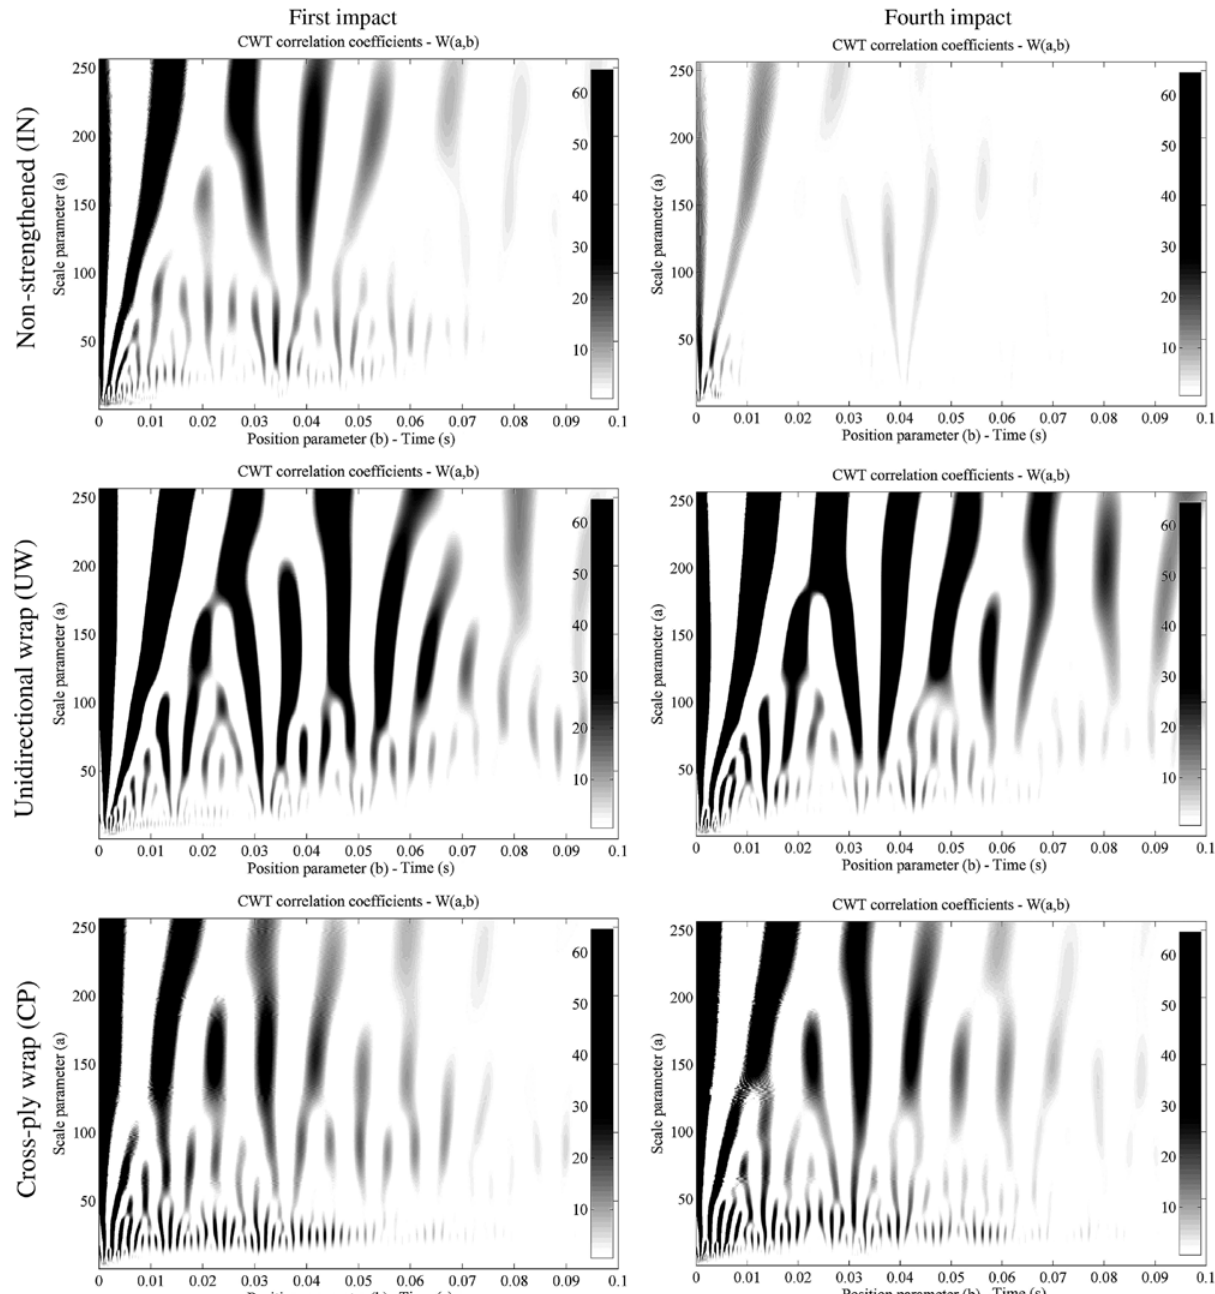
Figure 8: CWT coefficient distribution for acceleration